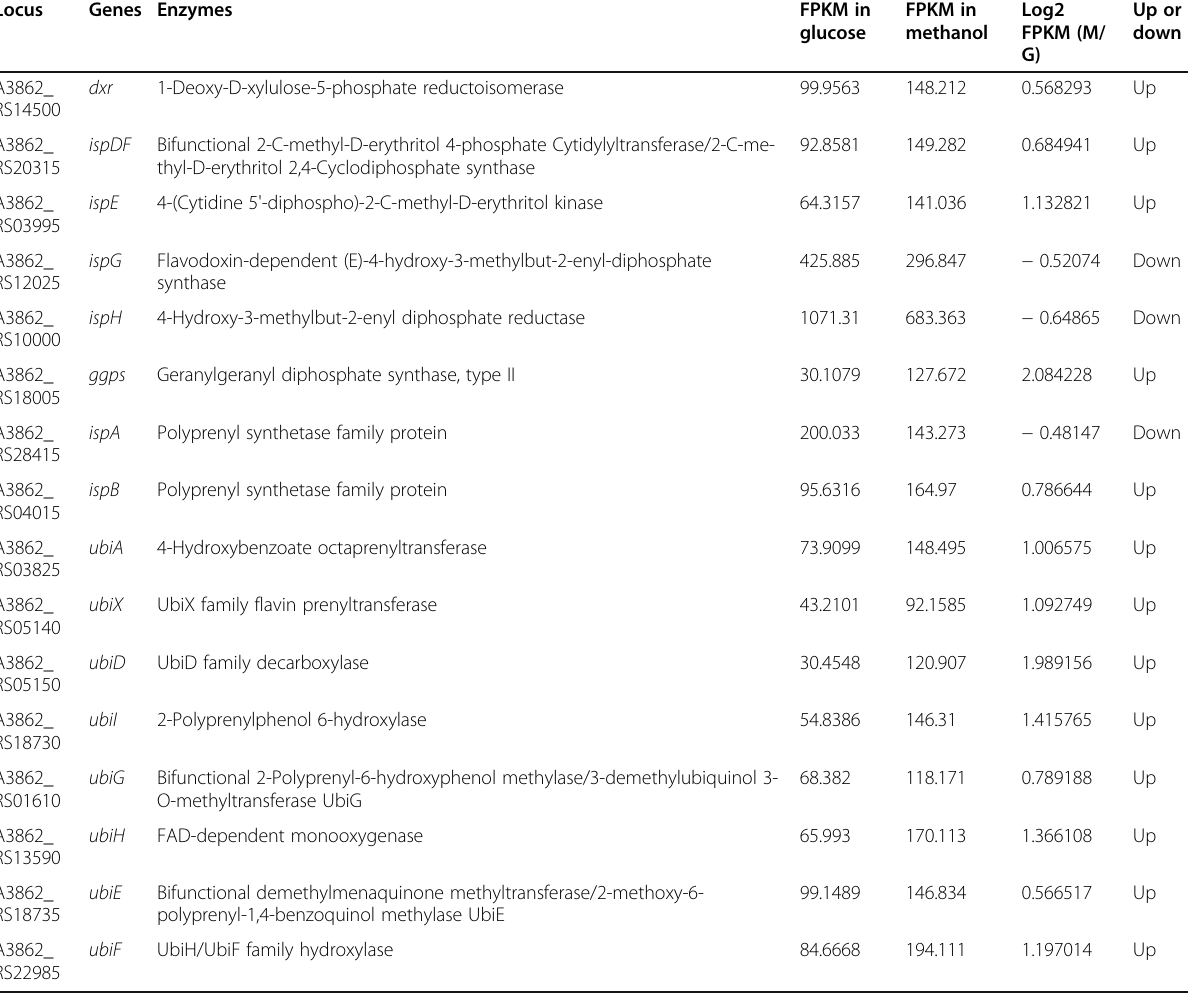
Table 3 FPKM values of CoQ 10 synthesis-related genes based on RNA-seq analysis Locus Genes